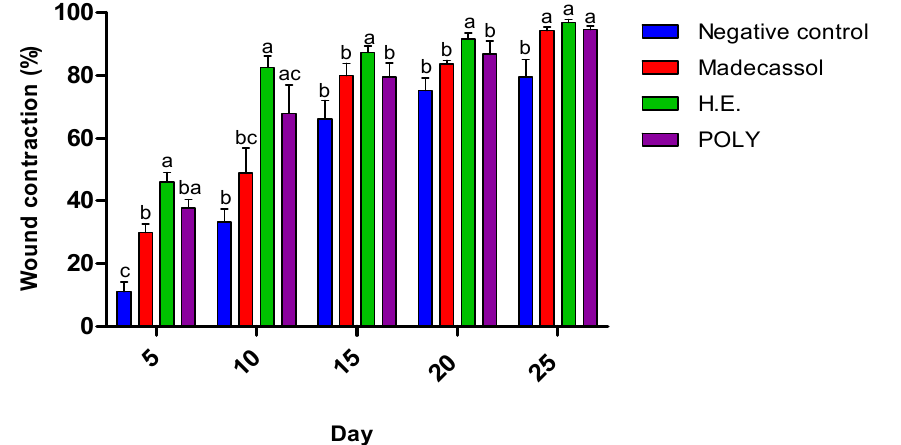
Figure 6. Burn healing activity of the hydro-ethanolic (H.E.) and polyphenolic (POLY) extracts of P. sativum Hoffm. and the control groups. Superscript letters (a, b, c) indicate the significant difference between treatments at p < 0.05. Table 8. Wound size (cm 2 ) of the hydro-ethanolic and polyphenols extracts of P. sativu m Hoffm. from day 1 till day 25.